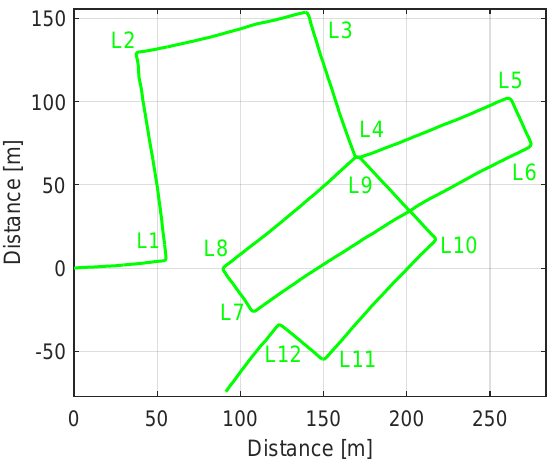
Figure 12. Trajectory computed using the MEMS-quality measurements with a set of biases equal to ( 0,0,0.05 ) ◦ · s − 1 . The detected corners are